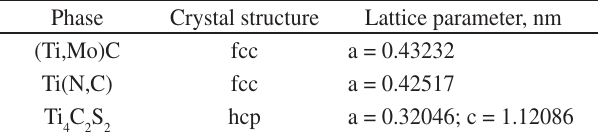
Table 3. Crystal structures and lattice parameters of the primary precipitates identified in the steel DIN W. Nr. 1.4970 after solution annealing.